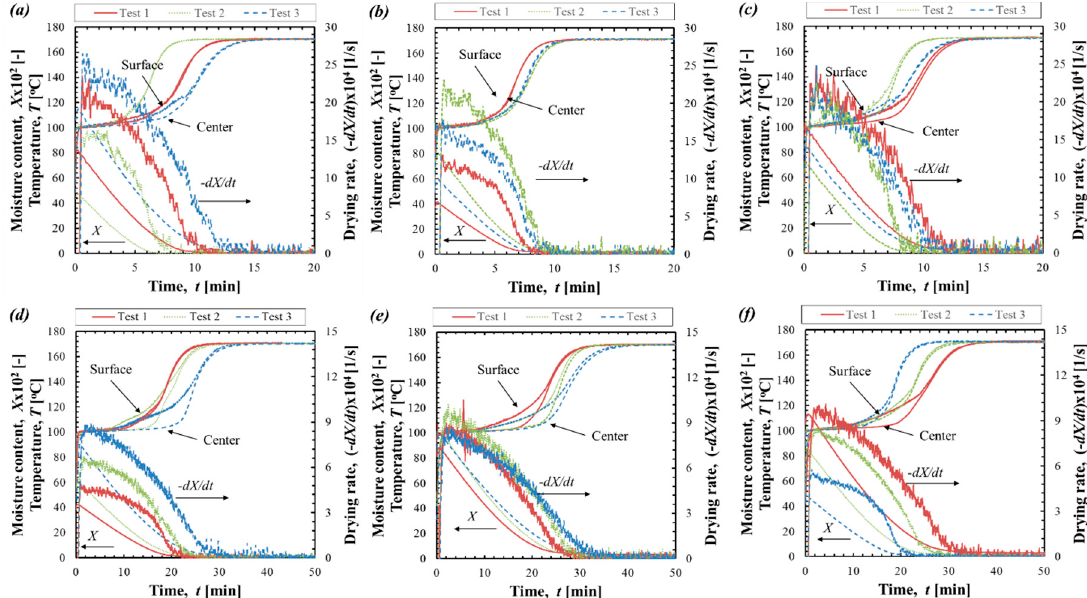
Figure 9. Exemplary drying behavior of lignite spherical sample at the test temperature of 170 °C: ( a ) T1 5 mm; ( b ) T2 5 mm; ( c ) T3 5 mm; ( d ) T1 10 mm; ( e ) T2 10 mm; and ( f ) T3 10 mm samples.